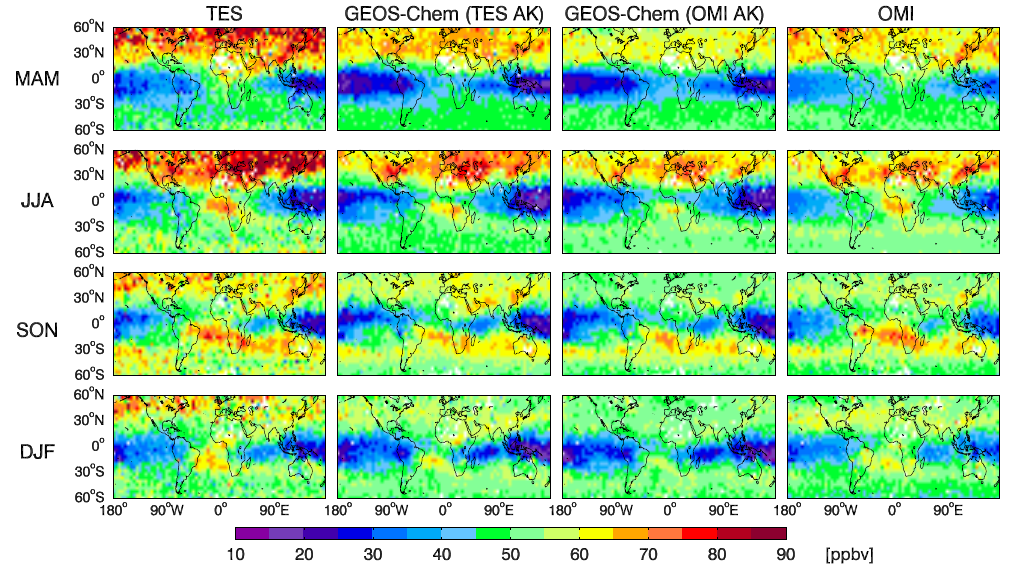
Fig. 3. Tropospheric ozone distributions in unit of ppbv from TES (left) and OMI (right) at 500hPa for the different seasons of 2006: March-April-May (MAM, uppermost row), June-July-August (JJA, middle top row), September-October-November (SON, middle bottom row), and December-January-February (DJF, lowermost row). The central two columns show the GEOS-Chem ozone simulation smoothed by the corresponding averaging kernels. All data use a single fixed a priori as described in the text and are averaged on the 4 ◦ × 5 ◦ grid of GEOS-Chem. The purple color represents relatively low values and the red color represents relatively high values. White areas indicate lack of data meeting the retrieval quality